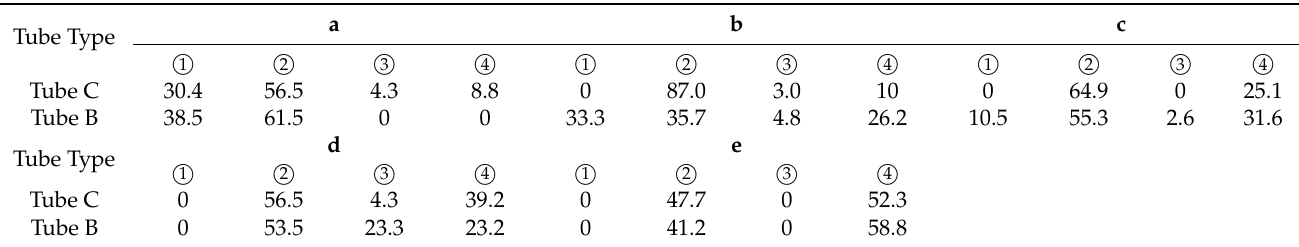
Table 10. The schedule of movement posture probability for seed delivery. unit: (%). ( a )